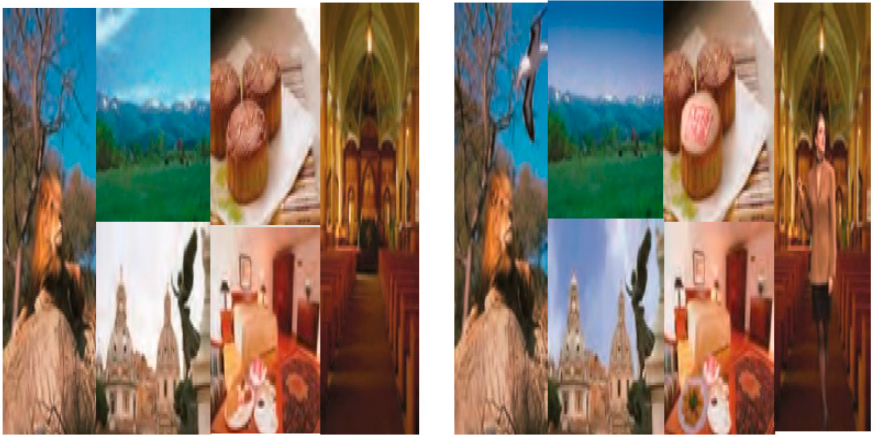
Figure 9. Comparison of authentic and tampered images.